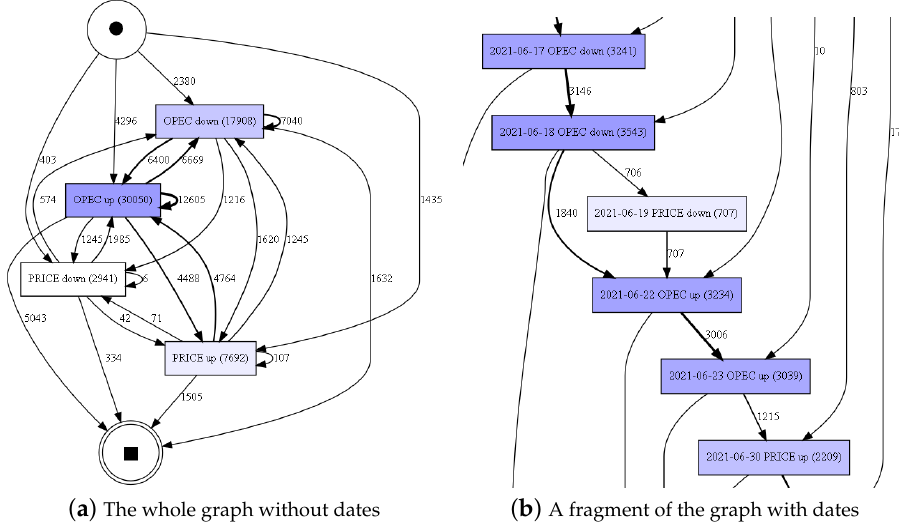
Figure 14. DFG with OPEC and PRICE factors.